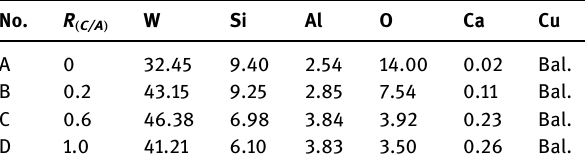
Table 1: Composition of the CuW composites prepared with dif - ferent R ( C/A ) , wt%